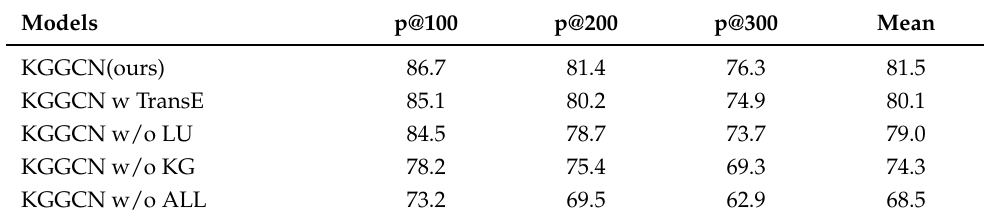
Table 4. Ablation study on the NYT-FB